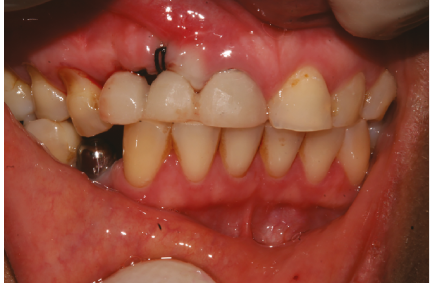
Figure 5: Installation of the temporary fi xed partial